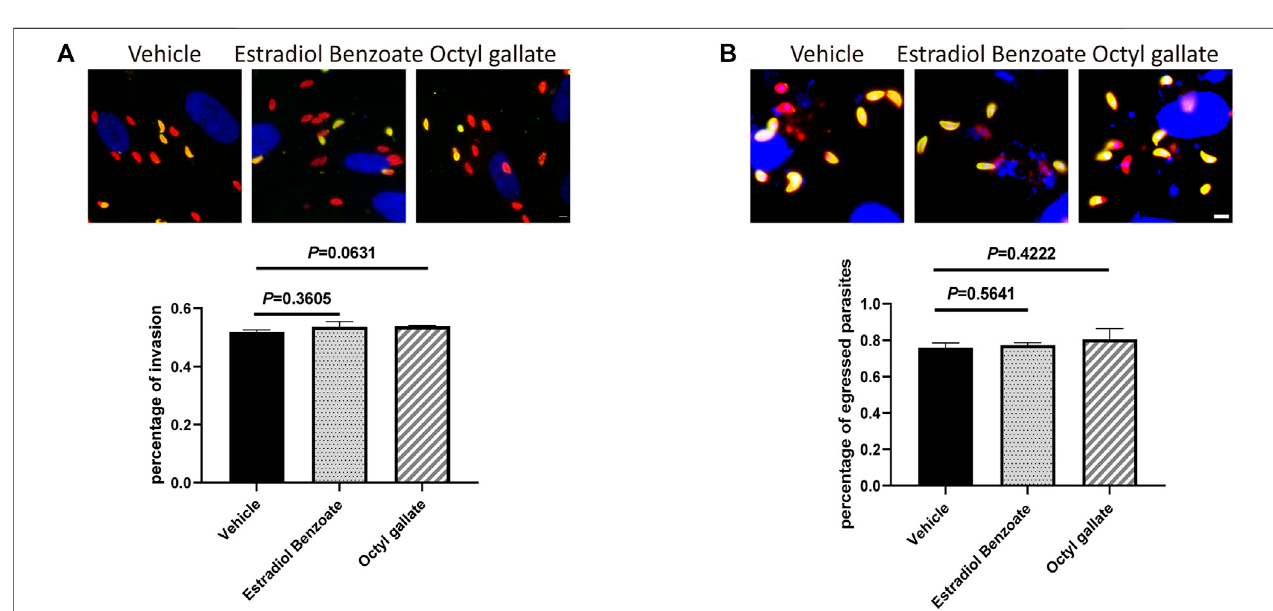
FIGURE 4 | Estradiol benzoate and octyl gallate have no effect on invasion and egression of T. gondii . (A) Representative immuno fl uorescence micrographs of intracellular and extracellular parasites are shown, and the percentage of invaded parasites after treatment was calculated, respectively. (B) Representative immuno fl uorescence micrographs of egressed parasites are shown, and the percentage of egressed parasites was calculated. The mean ± SD from one experiment representative of three independent experiments was shown. Scale = 5 μ m.